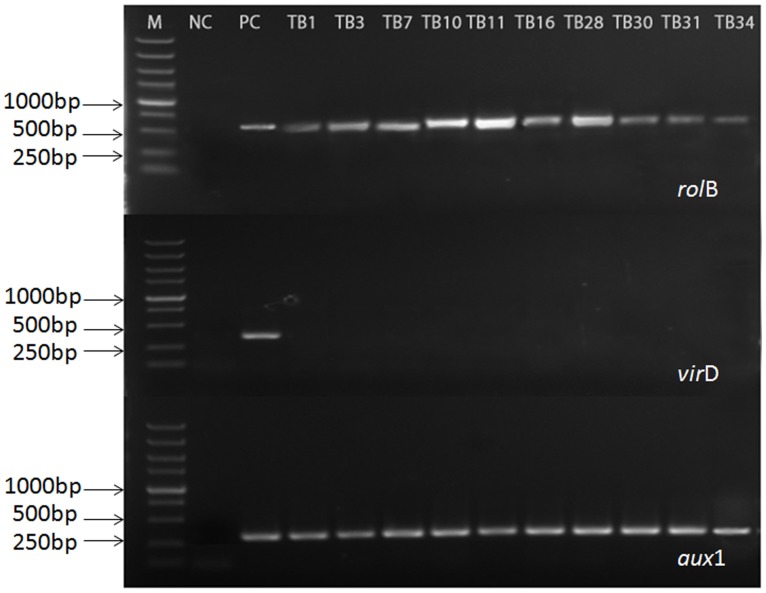
Polymerase chain reaction (PCR) analysis for the presence of rolB, aux1, and virD genes in hairy root lines of F. tataricum transformed by A. rhizogenes strain 15834. Lane M, marker. Lane 1, non-transformed roots [negative control (NC)]; Lane 2, plasmid DNA [positive control (PC)]; Lanes 4–13, transformed hairy root clones.